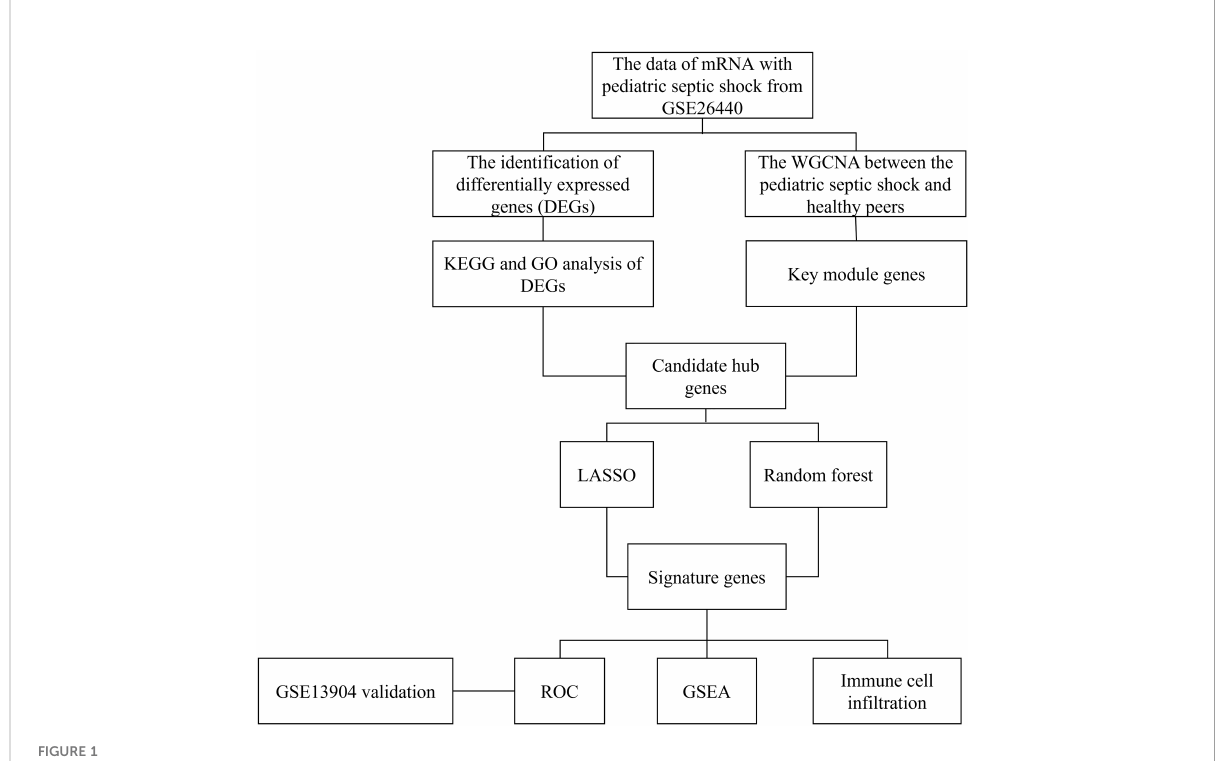
FIGURE 1 The fl ow chart of this